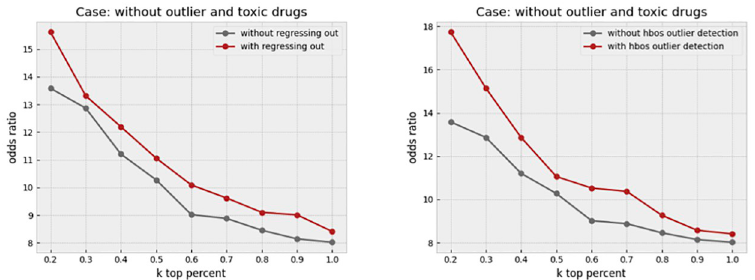
Fig 14. Effect of regressing-out and cell outlier detection. The left plot shows the increase in the odds ratio by regressing out the cell area from all other features in different k percentages when outlier and toxic drugs were removed. Improvement in the odds ratio becomes more significant when the toxic drugs are excluded from the analysis. The right plot shows that using histogram-based outlier detection improves the result in the same baseline case, where the outlier and toxic drugs were